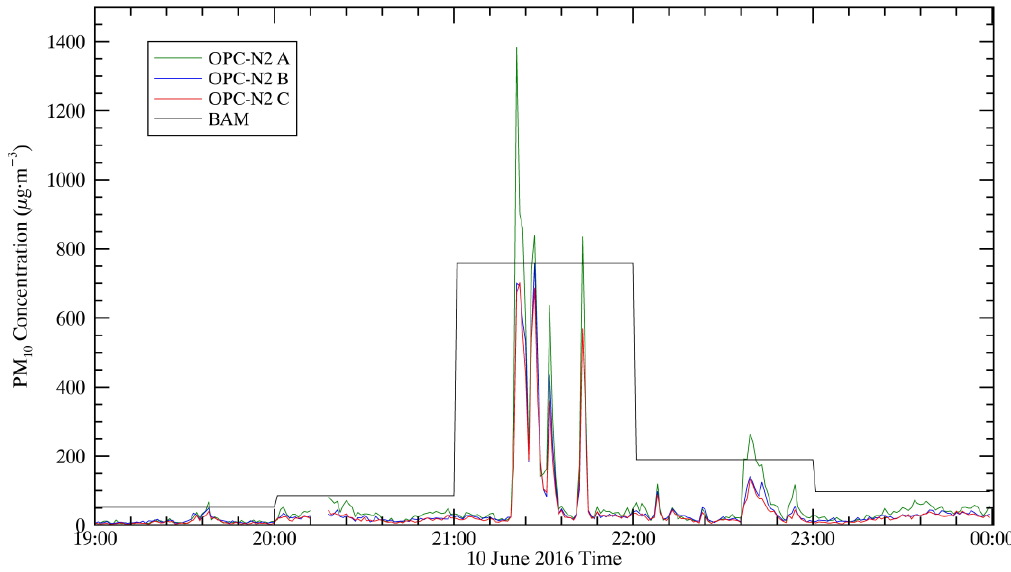
Figure 10. Hourly PM 10 concentrations measured by the BAM and one-minute PM 10 concentrations measured by the three OPC-N2 sensors on 10 June 2016. The BAM measurements at 21:00 would have been available at 22:00.